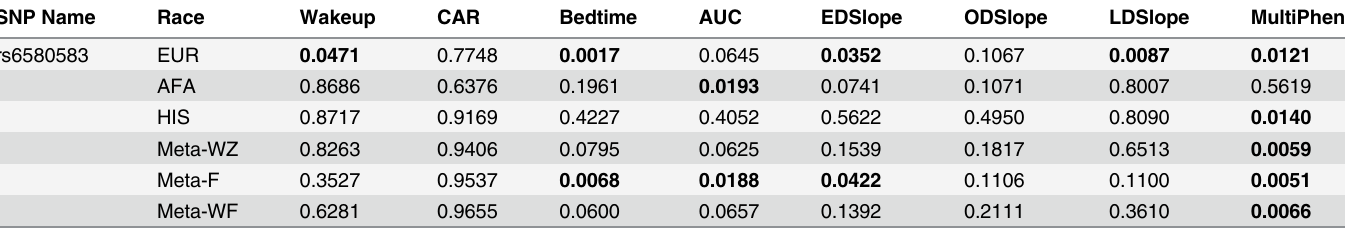
Table 4. P-values for the top SNP in ADRB2 gene associated with the seven cortisol features according to multi-phenotype meta analysis (Method